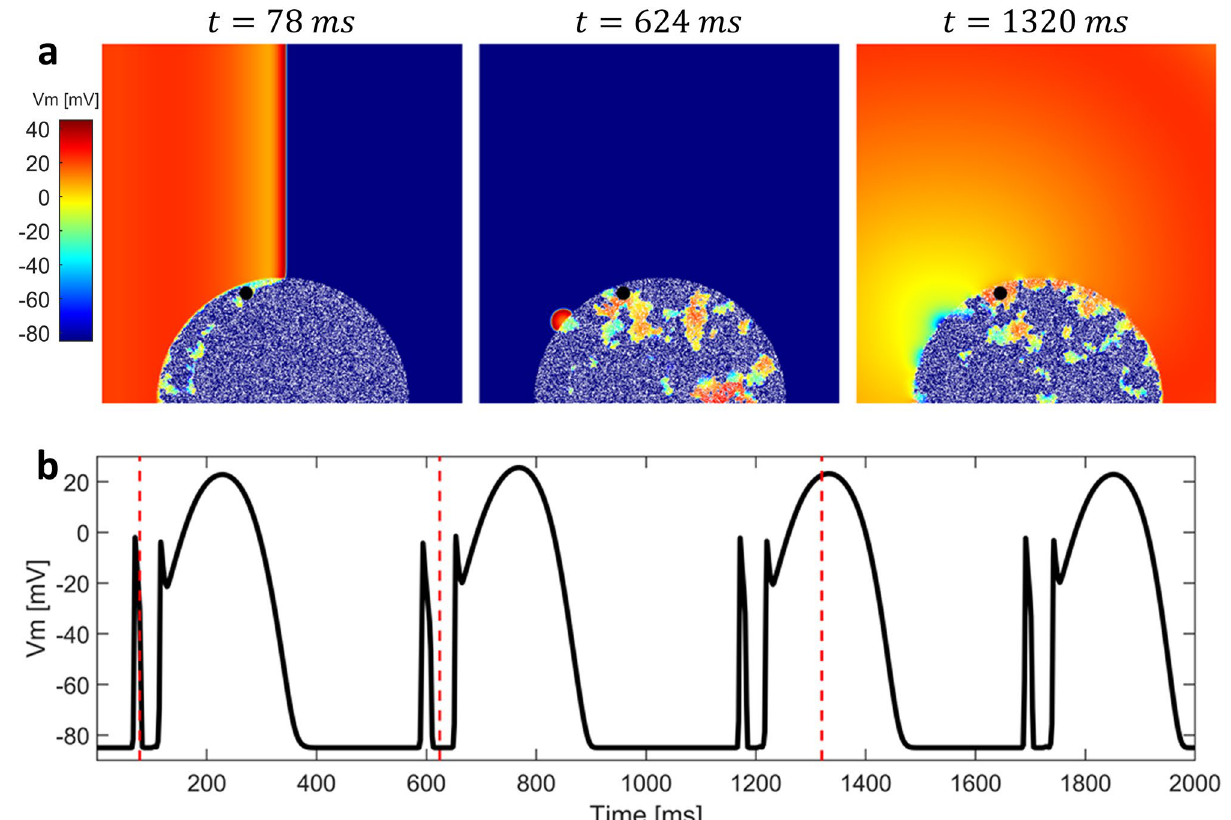
Figure 5. 2D simulation with altered electrophysiology in the BrS region with diffuse fibrosis. ( a ) Sequence of 0 snapshots taken from the 10 × 10 cm tissue model. The value of d w was 0.4, whereas the radius of the BrS region was 3.5 cm. Percentage of fibrotic tissue was set to 35% . Sustained reentry was triggered. ( b ) Membrane potential in the BrS region recorded in the point indicated by a black dot in the snapshots. Both orthodromic and antidromic P2R occurs at the interface between healthy and BrS regions. When diastolic interval is particularly low and/or electrotonic current is particularly high, delayed dome APs are induced. Red dashed lines indicate the time instants at which snapshots were